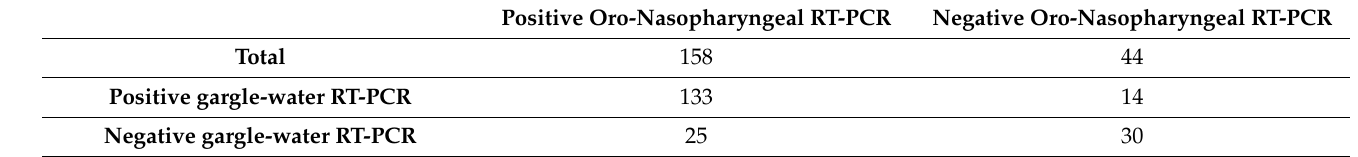
Table 5. The results of gargle water indirect RT-PCR with respect to paired oro-nasopharyngeal indirect RT-PCR